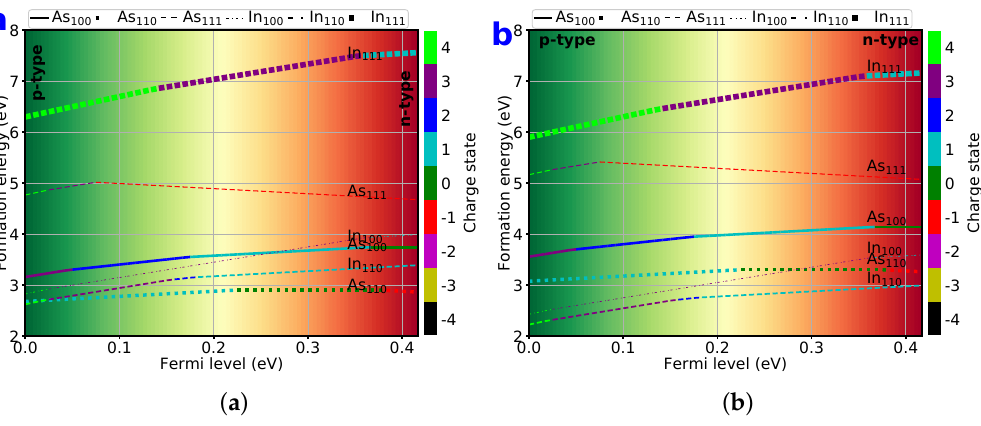
Figure 4. Formation energies as functions of E F under ( a ) As-rich and ( b ) In-rich environment for six labeled dumbbell type point defects in zb -InAs with all possible charge states from − 4 to + 4 marked with different